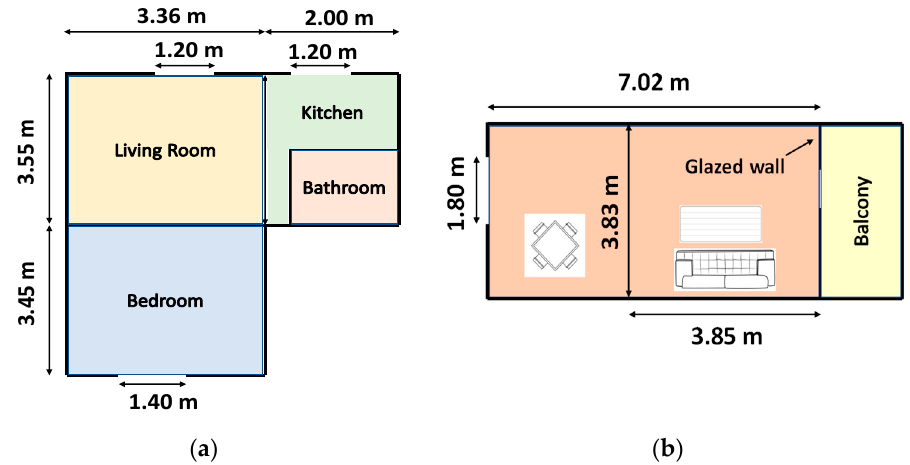
Figure 4. ( a ) Floor plan of a one-bedroom apartment in Southampton, UK. ( b ) Typical apartment living room configuration in San Sebastian, Spain [115]. Table 5. Summary of recorded measurements and the overall power performance of five main energy harvesting technologies available in buildings (Matiko et al. [115]).